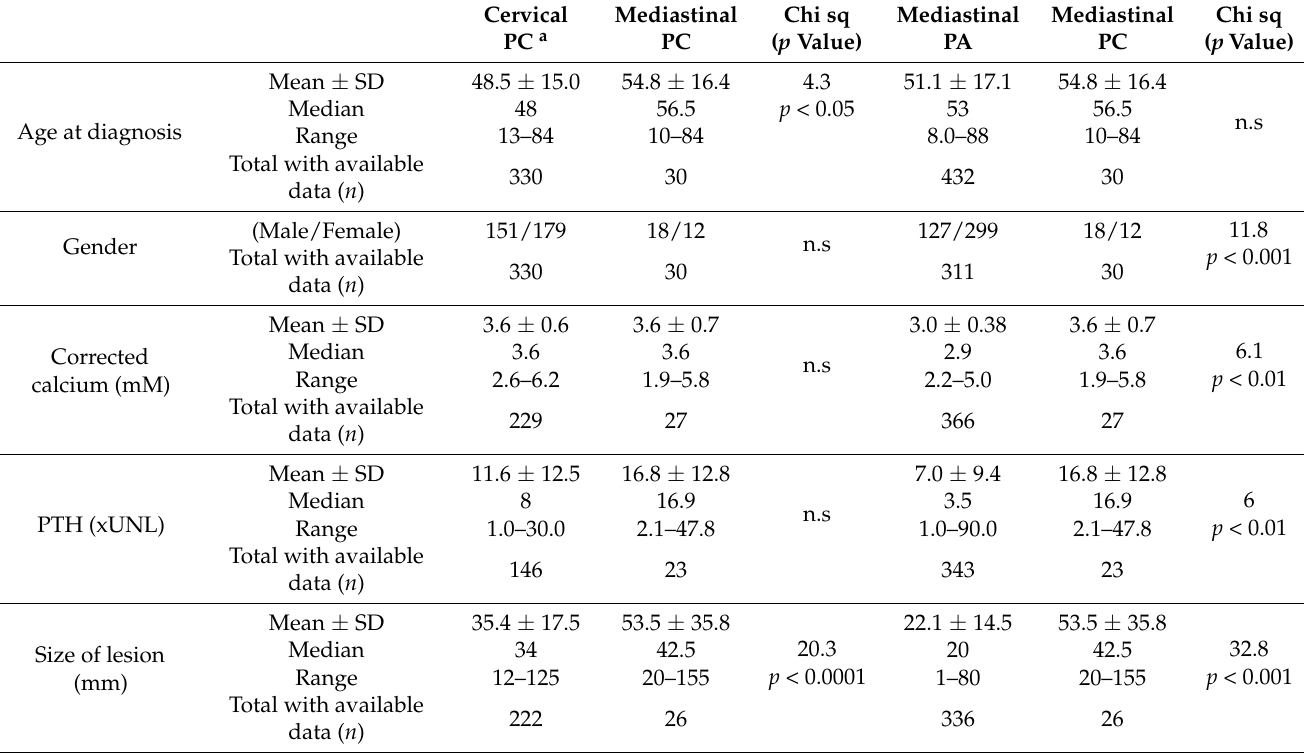
Table 1. Clinical presentation of cervical and mediastinal parathyroid